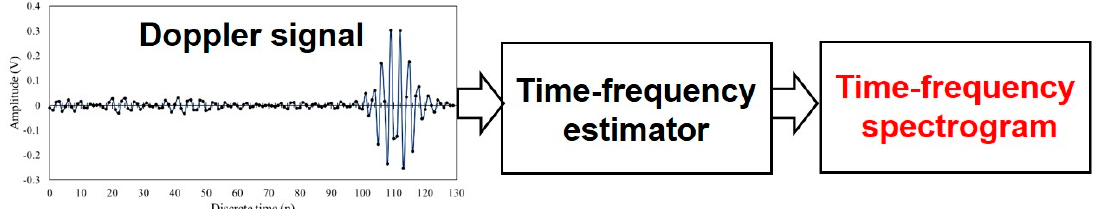
Figure 5. Diagram of a time ‐ frequency analysis of Doppler signal.